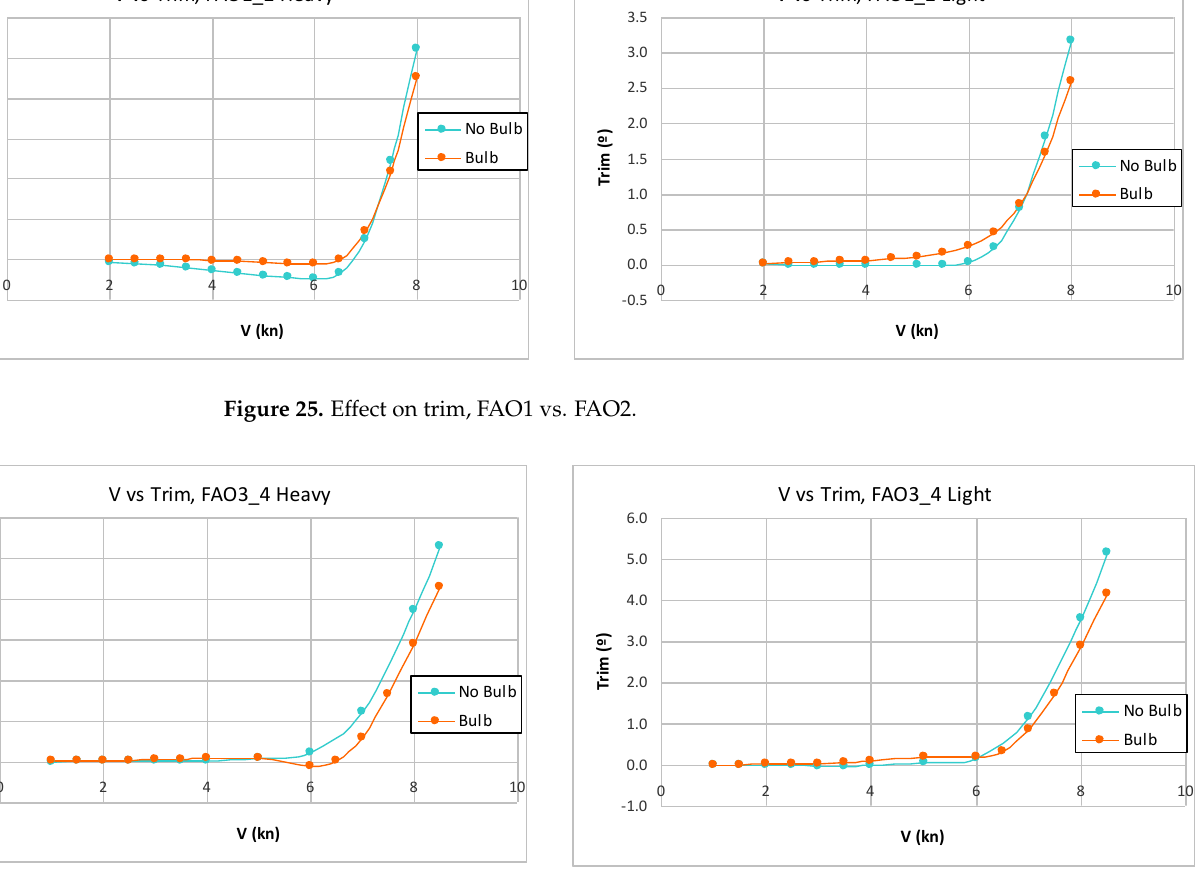
Figure 26. Effect on trim, FAO3 vs. FAO4.